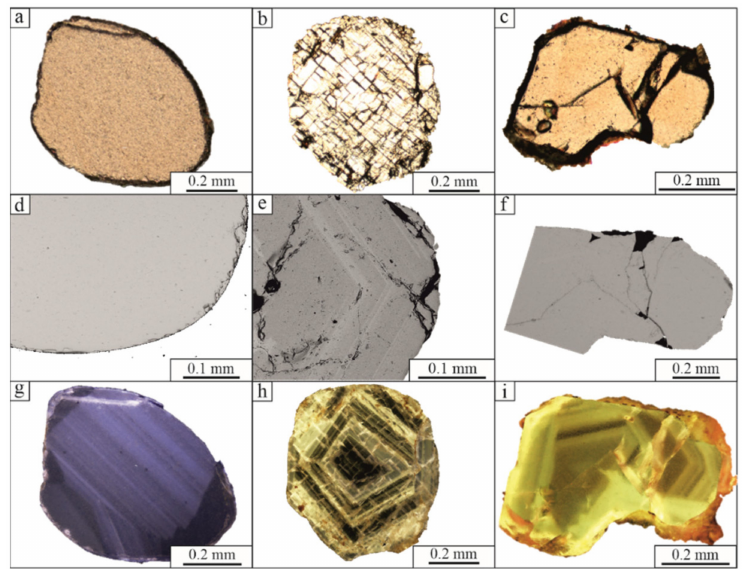
Figure 4. Image of three zircons from Lonedo ( a , d , g ); Le Fosse di Novale ( b , e , h ) and Castelletto di Rotzo ( c , f , i ). Optical image: ( a – c ); BSE images: ( d , e , f ); CL images: ( g – i ). Crystal b presents